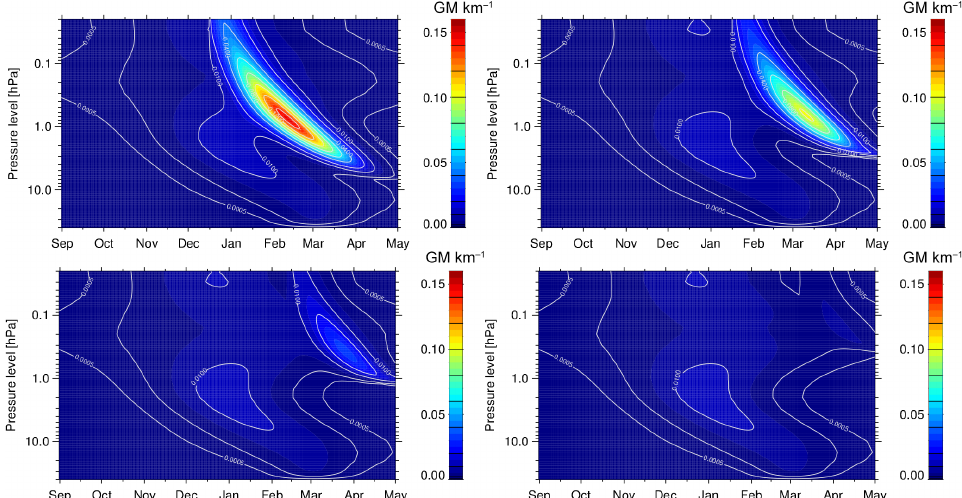
Figure 7. Temporal evolution of the vertical distribution of EPP-NO y differential amounts N d (z) during September–May in NH winter with ES events occurring on 15 December (upper left), 15 January (upper right), 10 February (bottom left), and 5 March (bottom right), resulting from the empirical model for a constant A p index of 10 (2002–2012